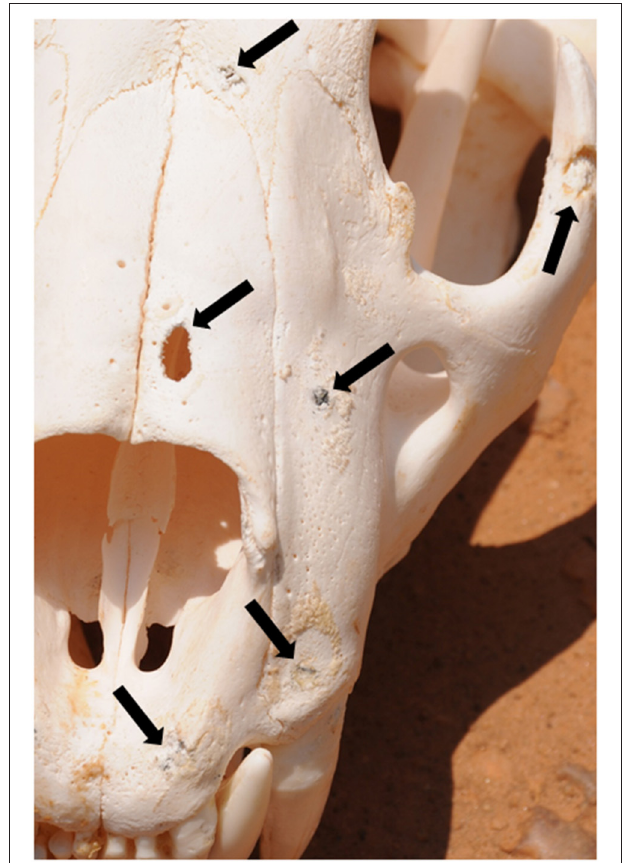
FIGURE 4 | Lion skull with old embedded shotgun pellets and lead fragments (arrows) in premaxilla, maxilla, frontal, and jugal bones and penetrating hole through nasal bone. Note chronic bony inflammation (raised circular granular areas) associated with embedded pellets. Gray metal marks left by the passing pellet are visible at the upper edge of the penetrating hole through the nasal